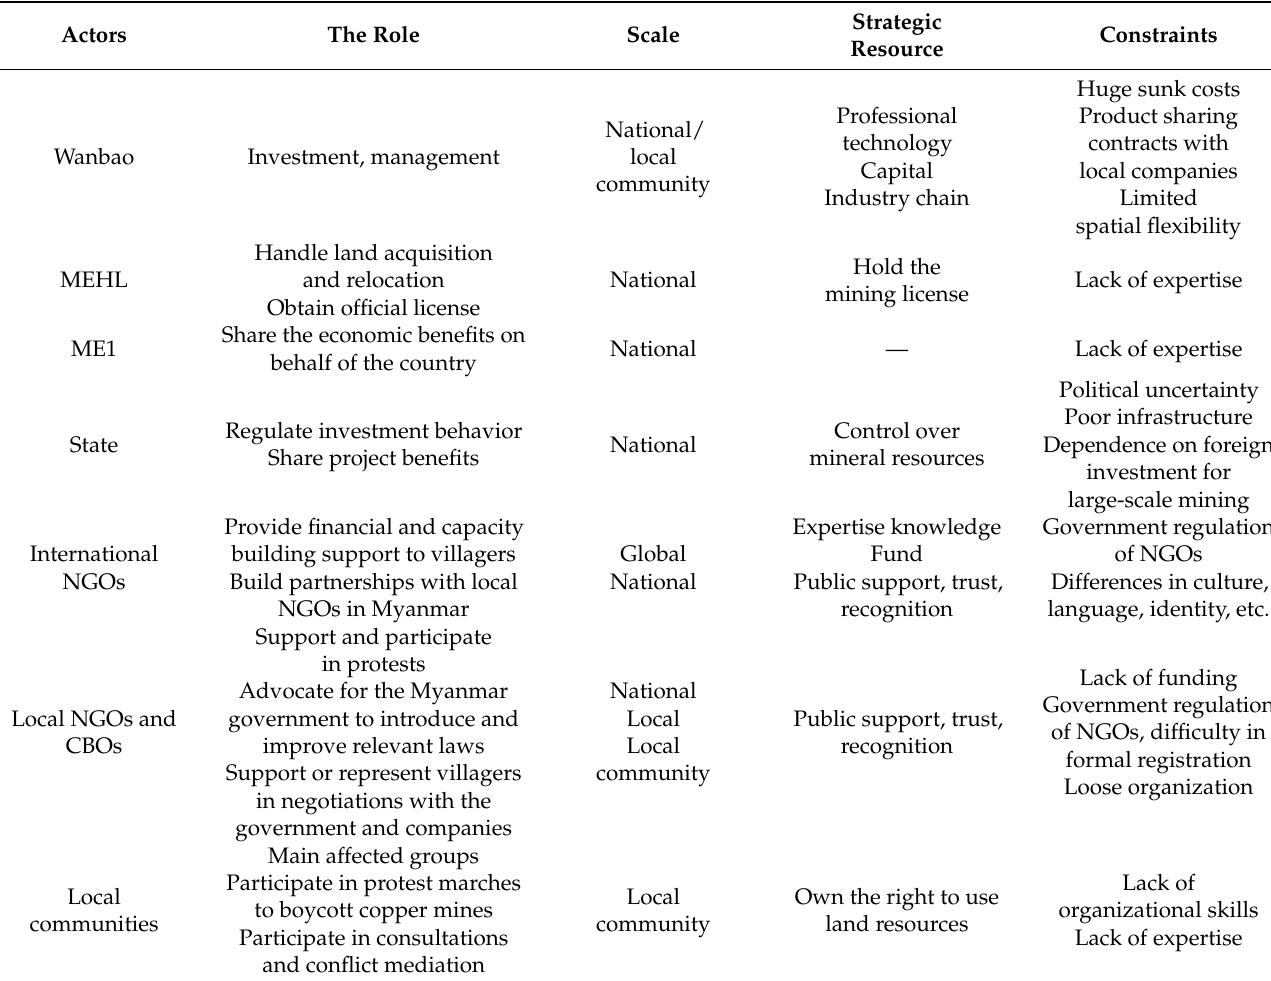
Table 2. The role of actors played in the Letpadaung copper production